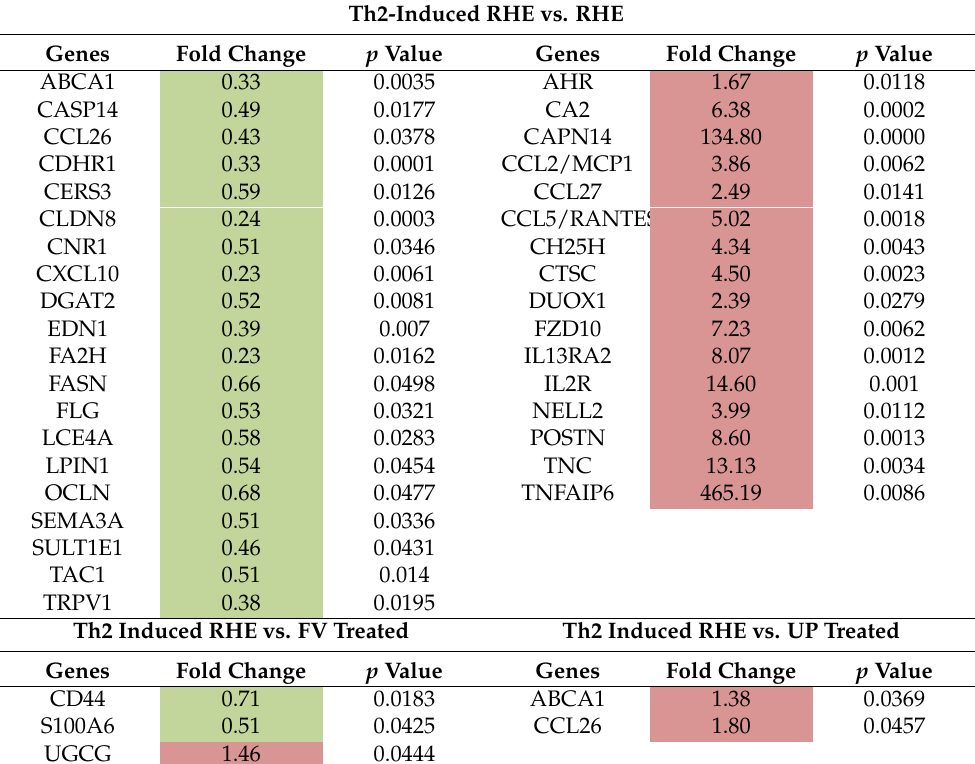
Table 2. Differentially expressed genes that are shown significant changes. The increases are in green and decreases in